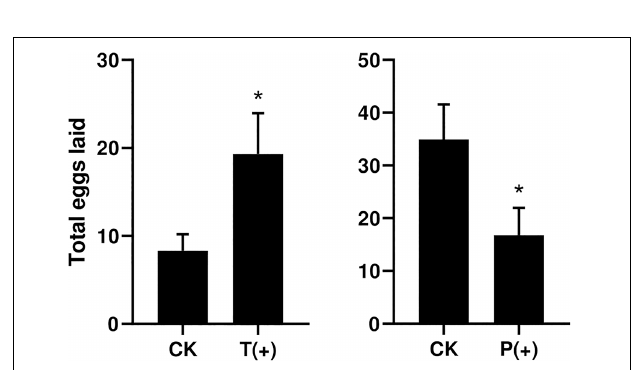
FIGURE 2 | Total number of eggs per dish of B. tabaci fed for 3 days in selective bioassays. ( ∗ Independent t -tests: P < 0.05).